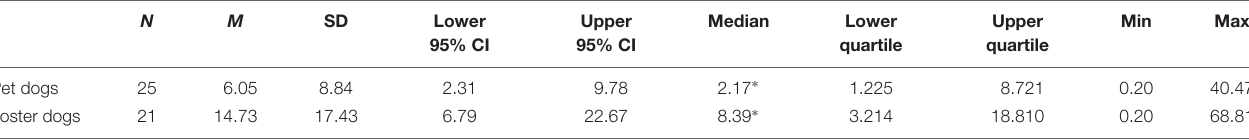
TABLE 10 | Serum prolactin levels (ng/ml) in pet dogs versus foster